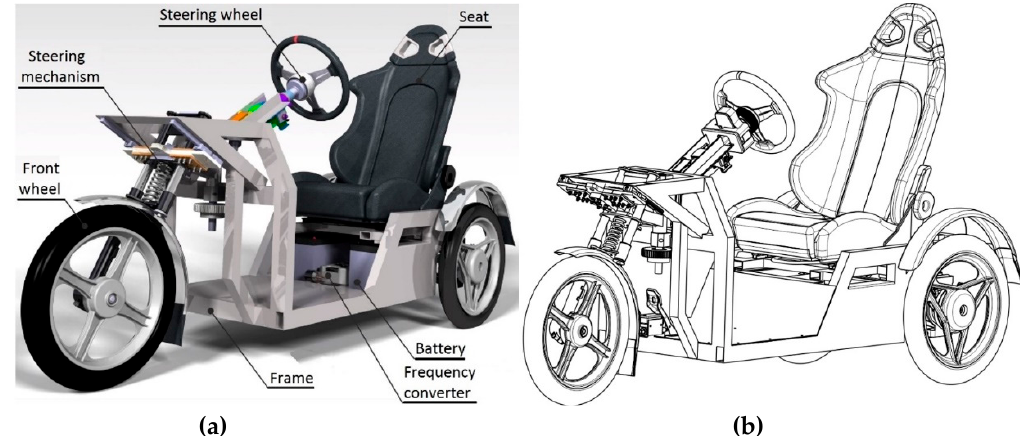
Figure 27. ( a ) The 3D CAD model of the designed vehicle and ( b ) the schematic drawing of the three-wheeled vehicle with the non-conventional mounting of the steered front wheel with the frame from the tested material EN AW 6063.T66.